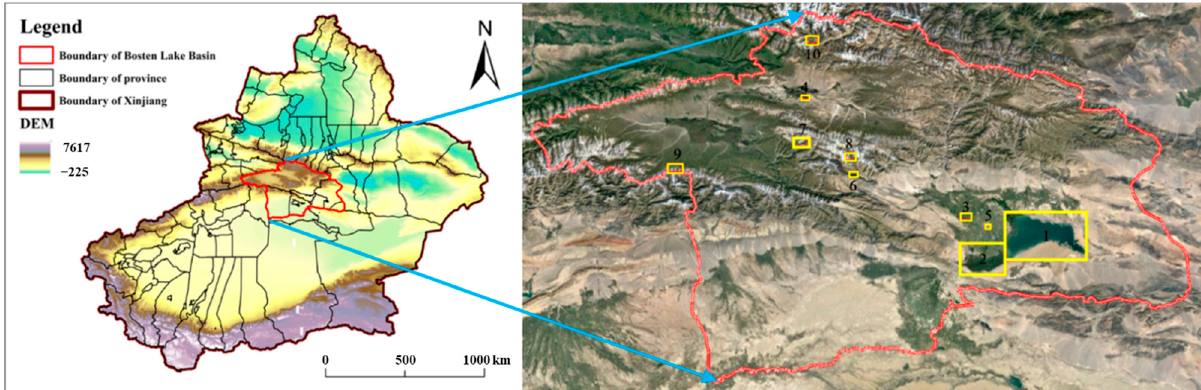
Figure 1. Schematic diagram of study area.